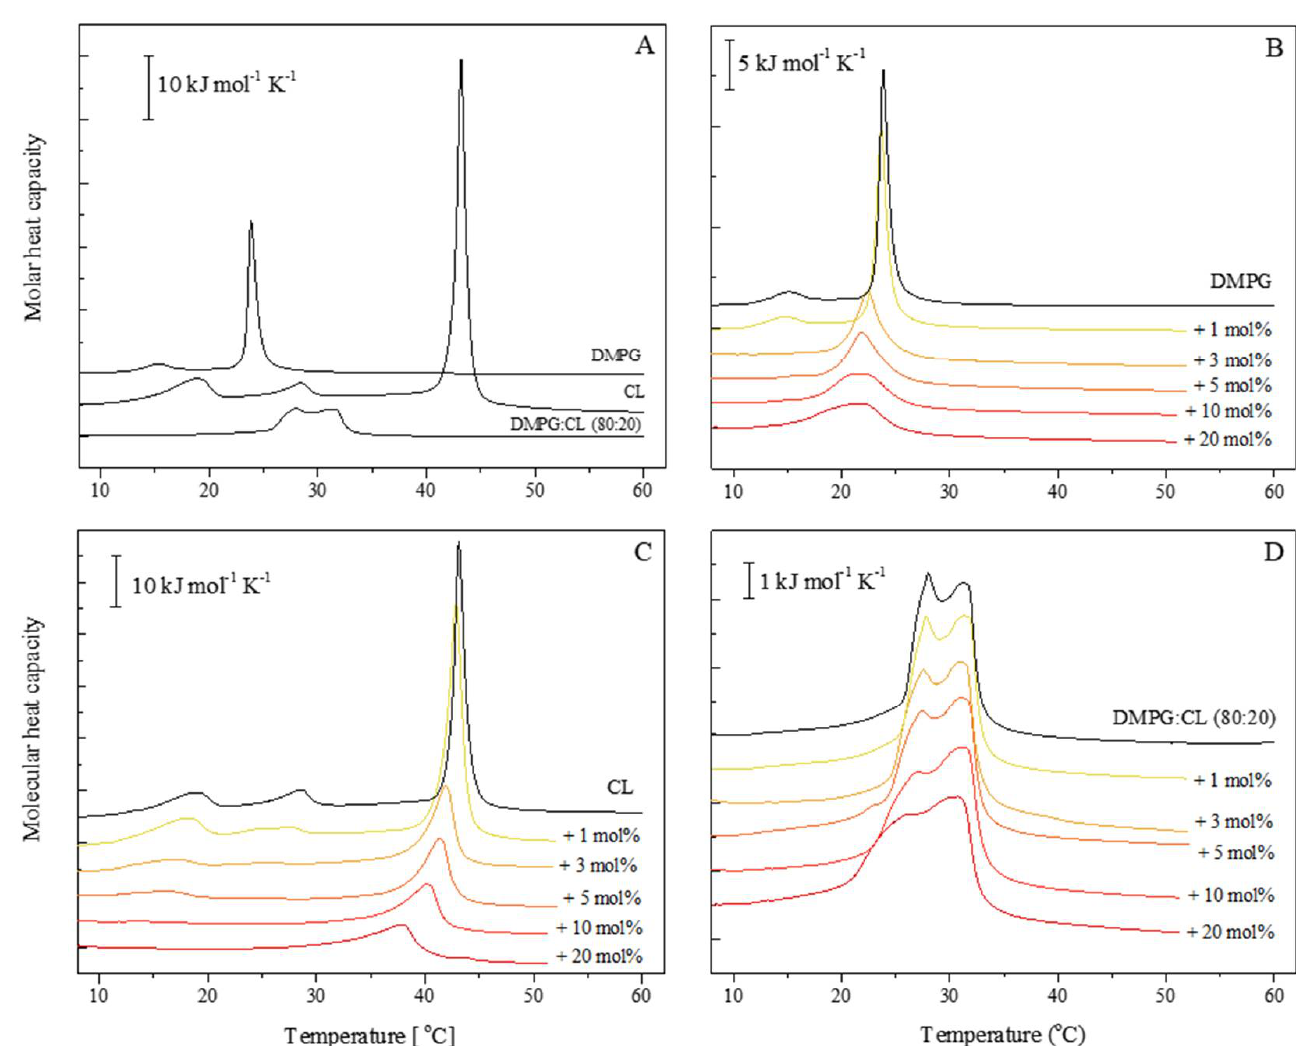
Figure 1. Representative DSC heating curves obtained for multilamellar liposomes of ( A ) DMPG, CL and their mixture DMPG:CL (80:20), and total carotenoid extract incubated with ( B ) DMPG, ( C ) CL, and ( D ) mixture DMPG:CL (80:20).